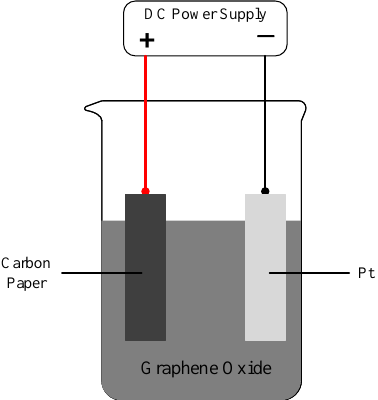
Figure 1. Illustration of the rGO/CP preparation.